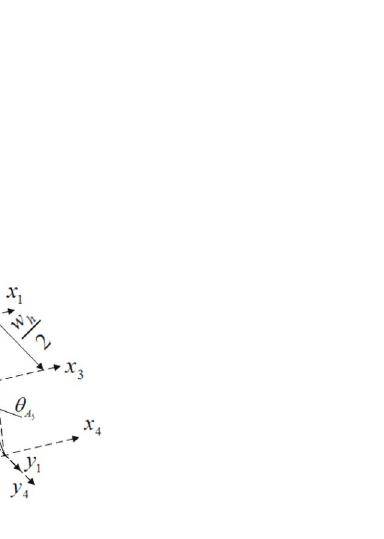
Fig 8. Calculation of braiding angle of internal cell